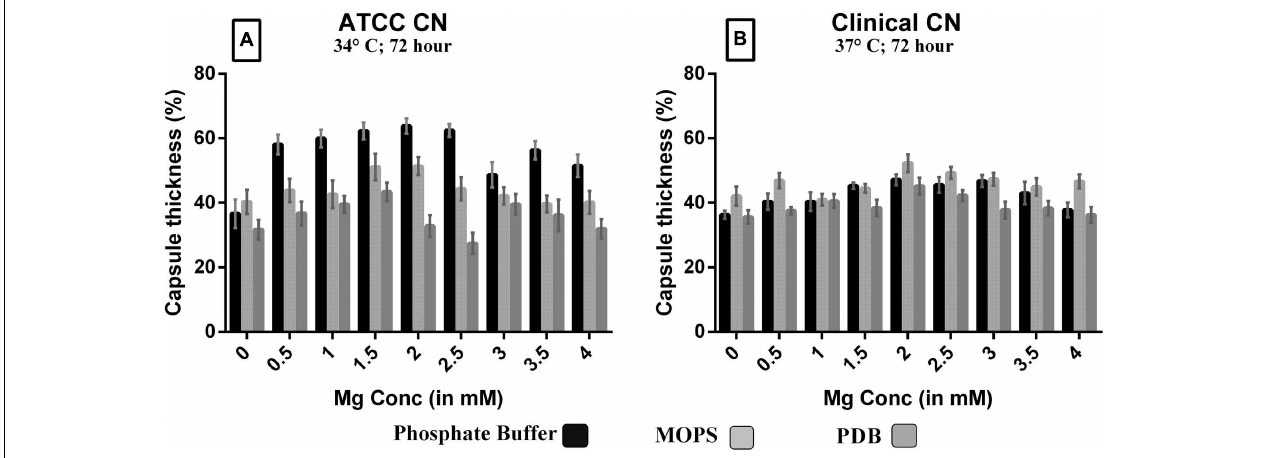
FIGURE 6 | Effect of Mg 2 + with phosphate buffer, MOPS and PDB on capsule induction with increasing Mg 2 + concentration (0.0 – 4.0 mM) in ATCC C. neoformans at 34 ◦ C, 72 h, pH 5.5 (A); clinical C. neoformans at 37 ◦ C, 72 h, pH 5.5 (B); 0.1% glucose used as a control. Y -axis represents capsule thickness (in %). The higher capsule size was observed with phosphate buffer + 2.0 mM Mg 2 + in ATCC C. neoformans (67%) whereas in clinical C. neoformans (58%) sample, PDB + 0.5 mM Mg 2 + . The cell size, capsule size and percentage of the capsule thickness for ≥ 8 cells per group is shown. Bars represent standard errors ( p < 0.0001).